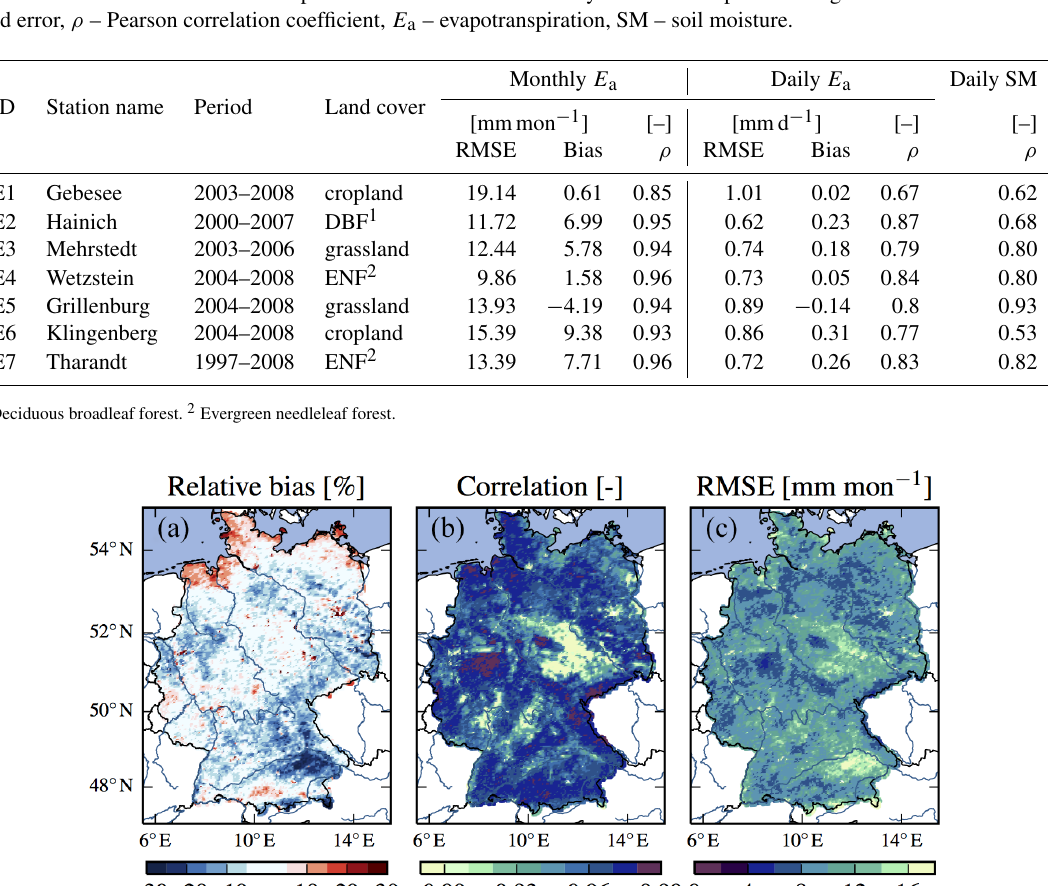
along the coastal region in northern Germany. The